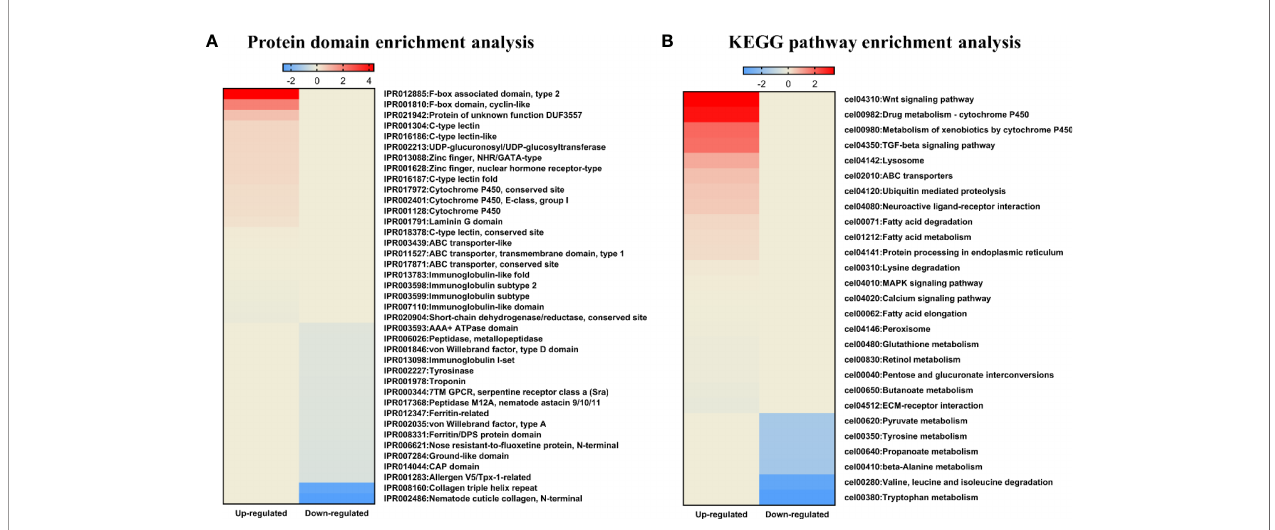
FIGURE 5 | KEGG pathway and protein domain enrichment analyses in C. elegans exposed to LGG. Heatmap depicting abundance of selected protein domain and KEGG pathways. Different colors represent different expression level as determined by Fisher ’ s exact test p values ( − log 10 ). Red color represents up-regulated expression and blue color represents down-regulated expression. Each row denotes the categories of the protein domain and metabolic pathway. (A) Protein domain enrichment results of upregulated and downregulated proteins. (B) KEGG pathway enrichment results for upregulated and downregulated pathways.